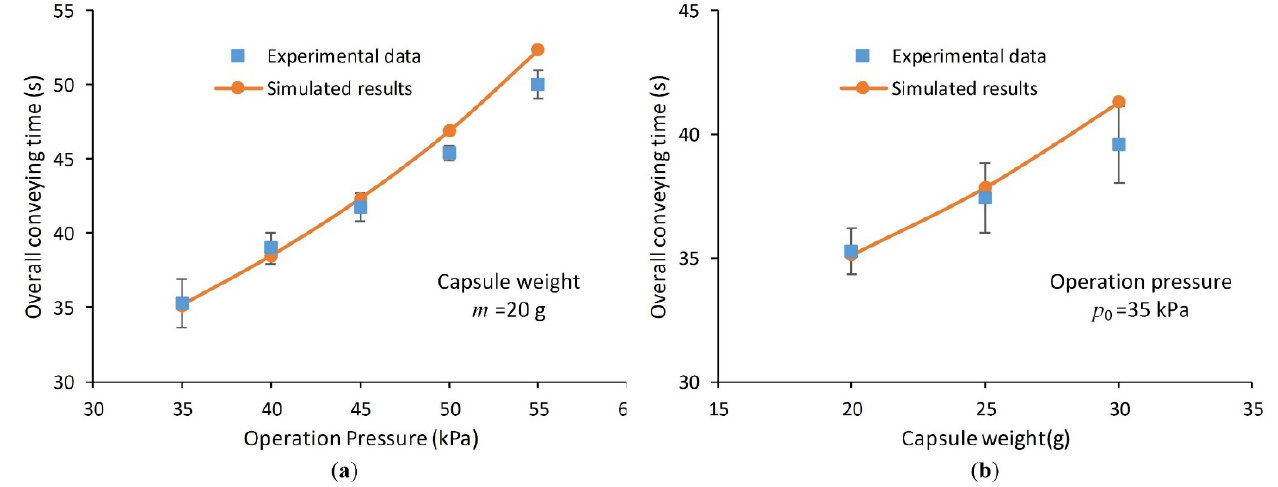
Figure 9. Experimental and simulated overall conveying time with various operation pressure ( a ) and capsule weight ( b ).